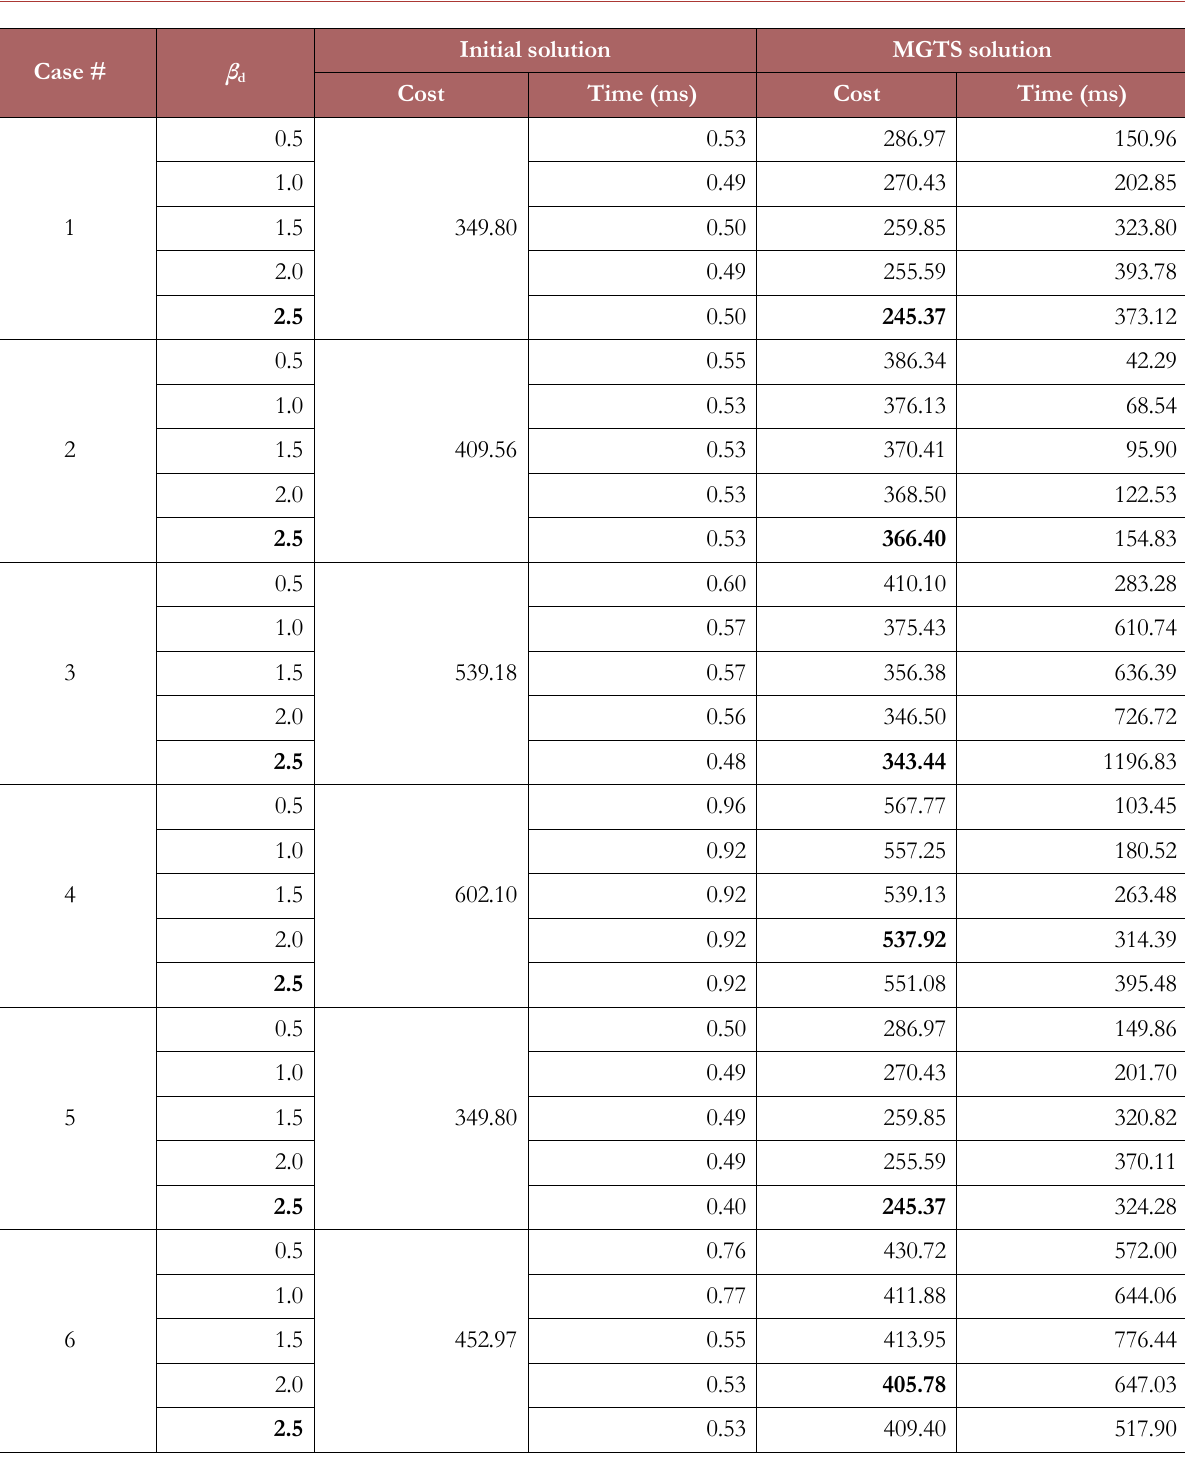
Table 2. Results obtained with different values of β in the refinement